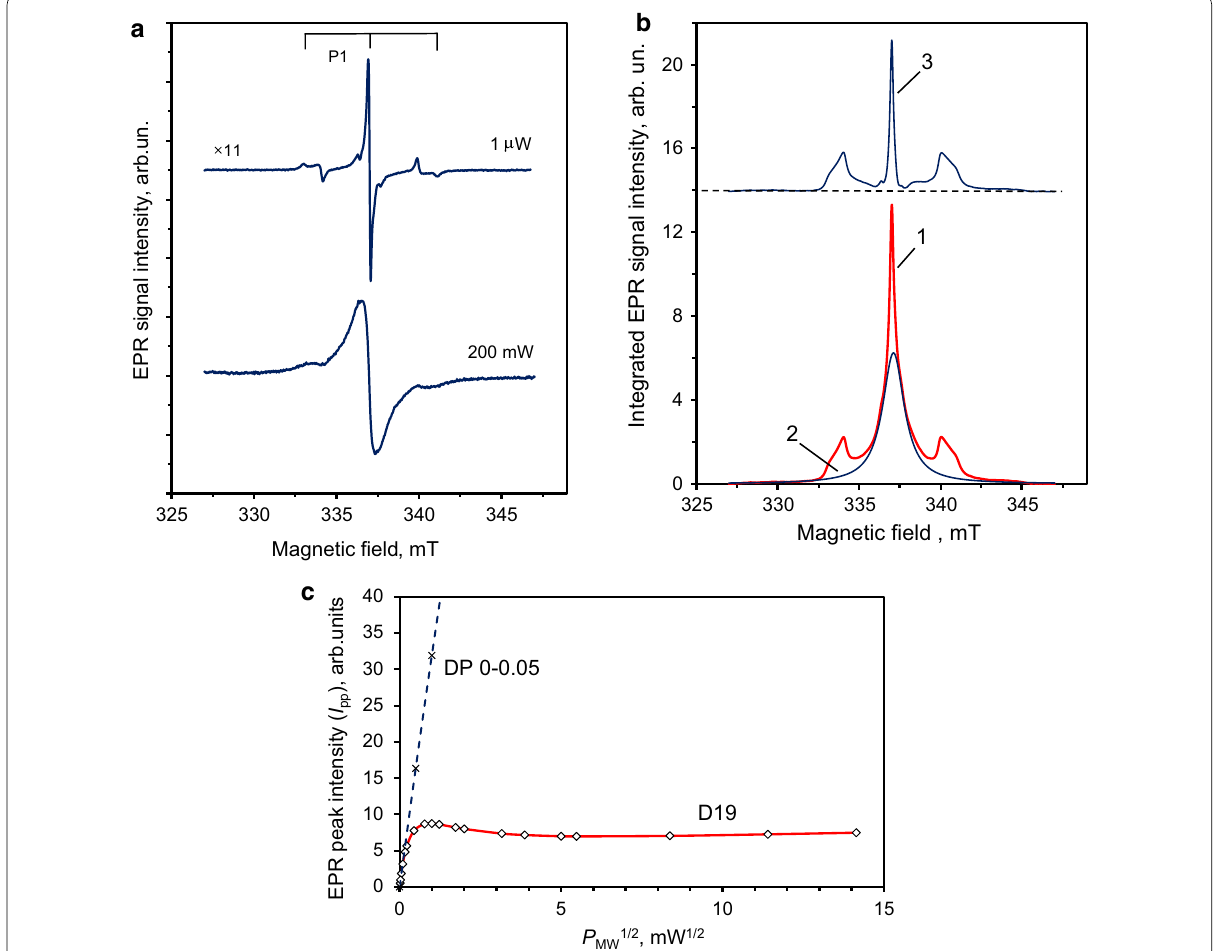
Fig. 7 The main first-derivative EPR signal of D19 diamond crystals at low and high microwave powers ( a ), decomposition of the integrated EPR signal into components related to two groups of spins ( b ), and the corresponding saturation trend of the peak intensity of this EPR signal versus the square root of microwave power in the range up to 200 mW ( c ). The triplet HFS structure of the EPR signal of the P1 centre (substitutional nitrogen) is clearly distinguishable in ( a ). In ( b ): curve 3, having triplet structure, corresponds to the EPR spectrum of only P1 centres. In ( c ): the dashed straight line is the I pp vs ( P MW ) 1/2 dependence for DP 0–0.05 polycrystals given for reference. Four experimental points at P MW 0.5, 1, 2, 4 mW were used for = its plotting (two of them are not presented here). Microwave frequency ν 9.44 =